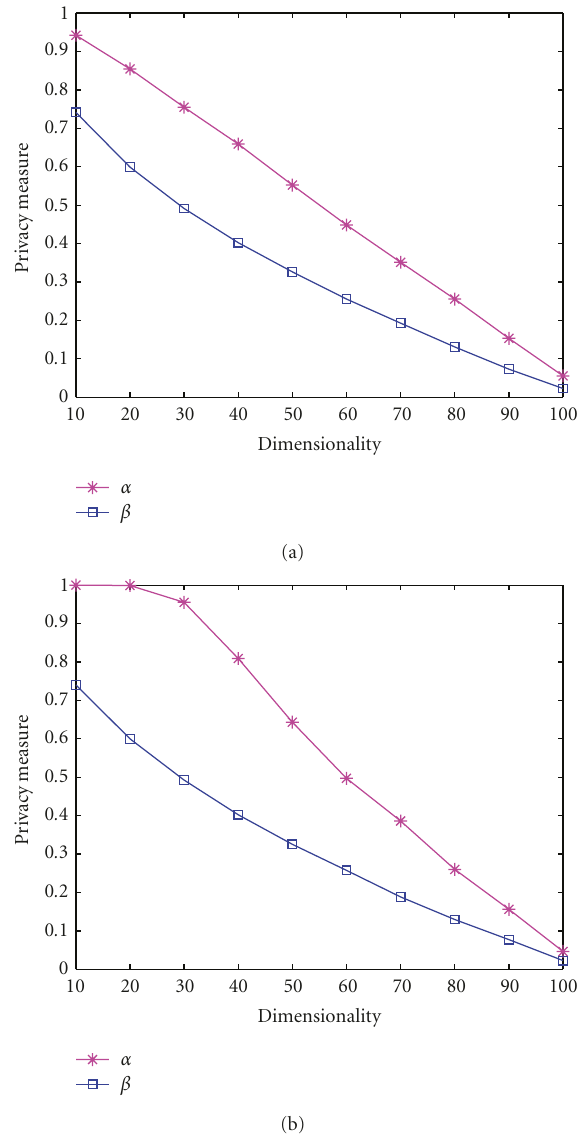
Figure 5: Privacy measure as a function of dimensionality. (a) random vectors, (b) PCA feature